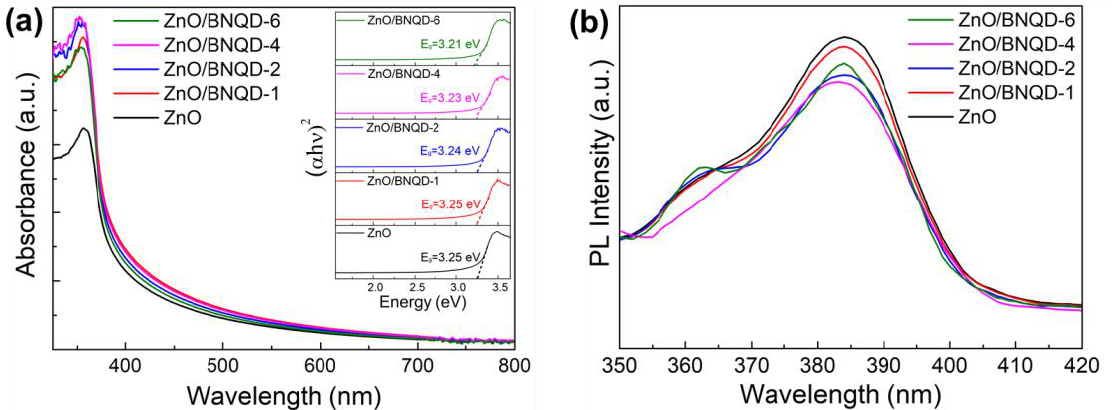
Figure 4. ( a ) UV-visible absorption spectra and ( b ) PL spectra of ZnO and different ZnO/BNQD nanocomposites. Inset showing the bandgap energy from UV-visible absorption spectra.